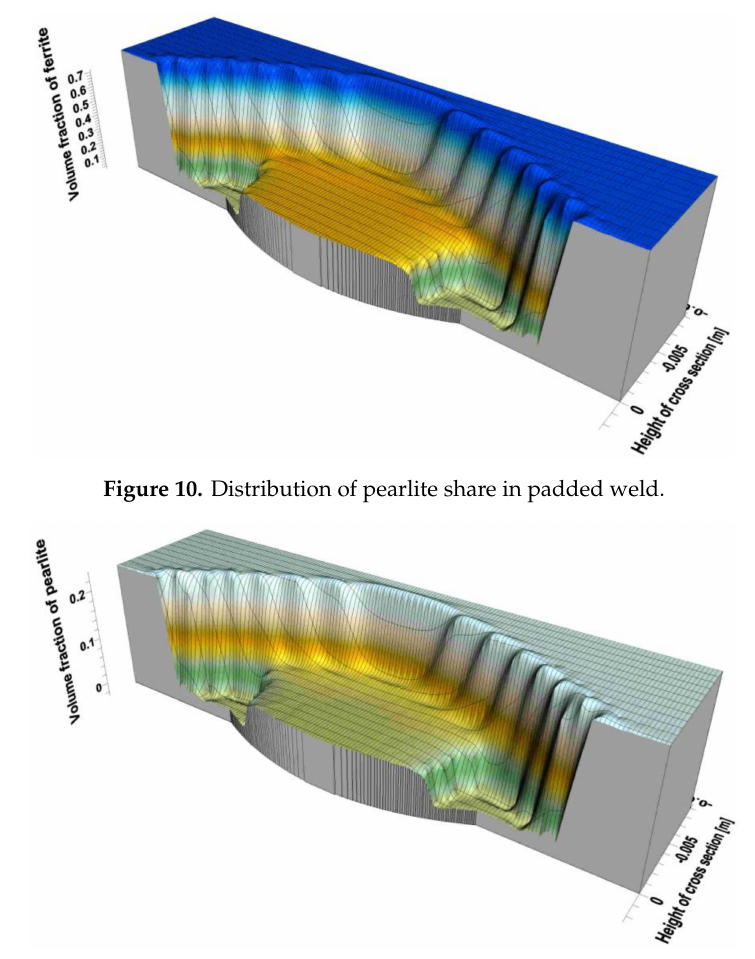
Figure 11. Distribution of ferrite share in padded